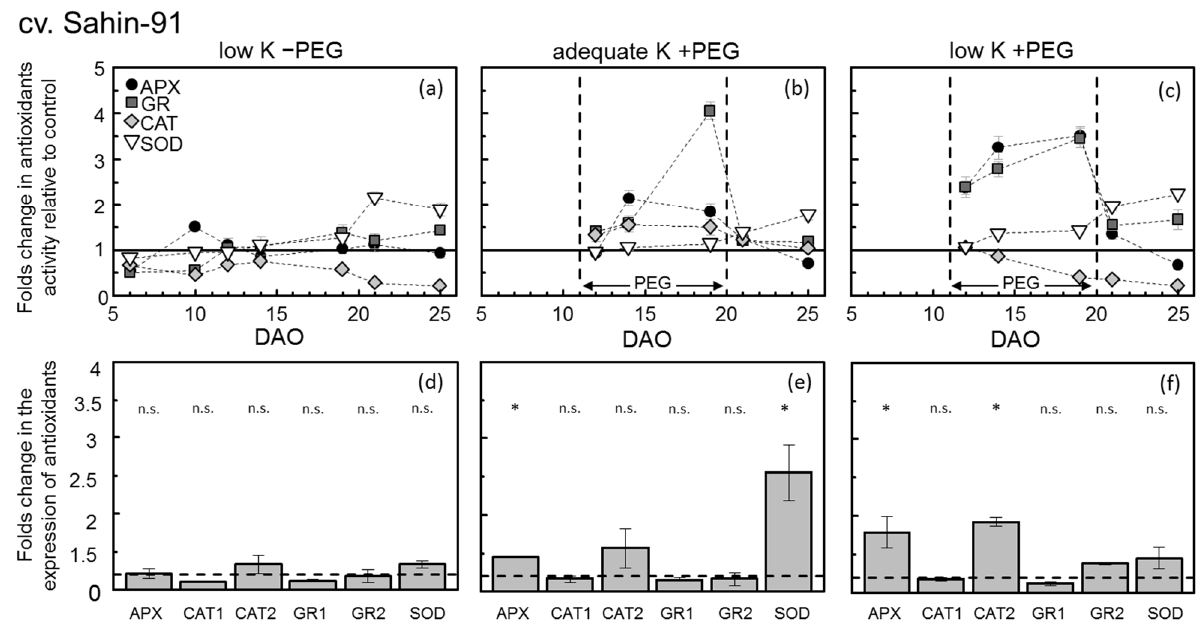
Figure 4. Temporal course of antioxidant (APX, GR, CAT, SOD) activities in fully expanded young leaves (above) 5–25 days after the onset of K treatments (DAO) and the relative gene expression at 14 DAO (below) of barley (cv. Sahin-91) grown in a nutrient solution under two levels of K supply (adequate K: 0.8 mM K+; low K 0.04 mM K+) without and with a PEG-induced water deficit ( − PEG; +PEG). On each sampling day, values of the treatments “low K − PEG”, “adequate K +PEG” and “low K +PEG” are expressed as fold changes in comparison to control (“adequate K − PEG” = 100%, represented by the solid horizontal line in each plot). Symbols represent means ± SE ( n = 6). In the gene expression plots, the dashed horizontal lines similarly represent the control treatment (“adequate K − PEG” = 1), and the bars reflect the fold changes of the selected genes in comparison to control. GR1 and GR2 represent chloroplastic and cytosolic glutathione reductase, respectively. SOD; chloroplastic superoxide dismutase, CAT1 and CAT2; two catalase gene copies and APX; peroxisome type ascorbate peroxidase. Each single combination of K-level × PEG-level × barley-variety for antioxidant activity is shown by the letters ( a – c ) and the exact same combination for gene expression is represented by letters ( d – f ). The significant expressions are shown with * ( p < 0.05). All samples were taken at 13:00 Table 3. Response of antioxidant activities (APX, GR, CAT, SOD) and ROS concentrations (H 2 O 2 , O 2 − ) to K, PEG and K:PEG. p -values of Kruskal–Wallis tests are shown. “+” for K, PEG and K:PEG indicates the following: (K) a significant increase in the respective trait from adequate (0.8 mM K + ) to low (0.04 mM K + ) K supply; (PEG) a significant increase in a trait from -PEG to +PEG under ade- quate K supply; (K:PEG) a significant increase in a trait from -PEG to +PEG under low-K supply. “- “ indicates a significant decrease in the above-mentioned traits. Statistics were performed on fully expanded young leaves samples taken between 11 and 19 DAO ( n = 18).